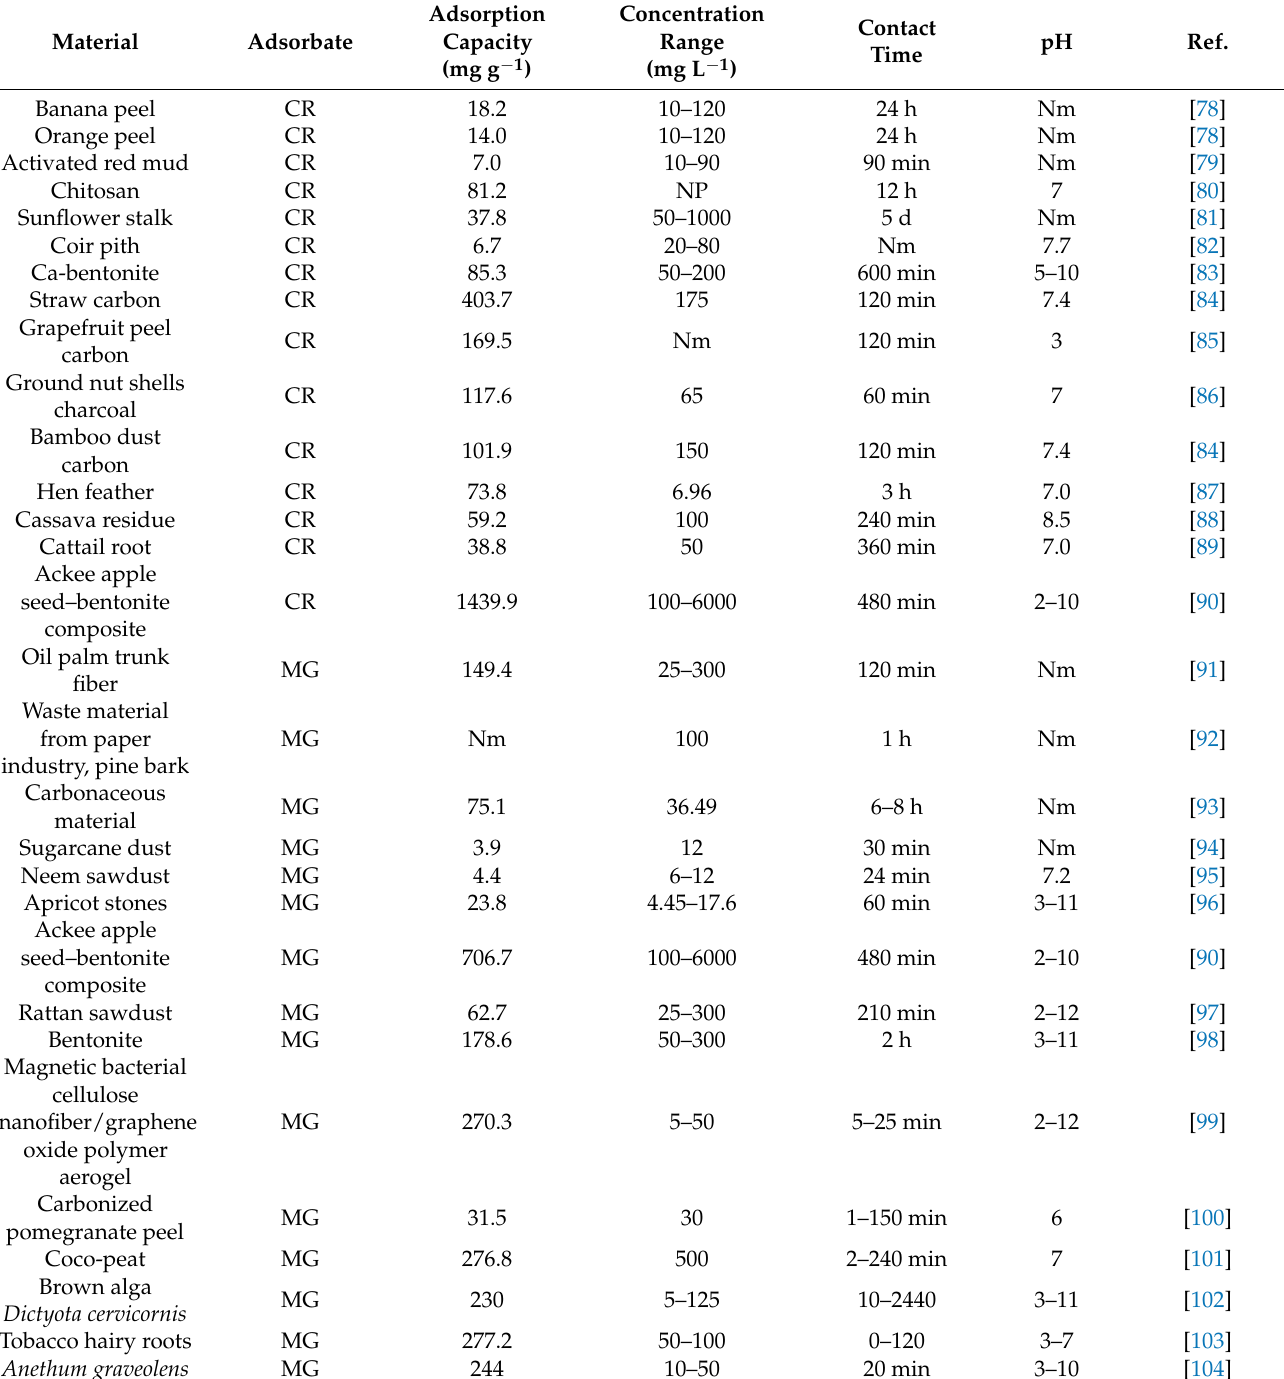
Table 4. Organic and inorganic adsorbents used for the removal of Congo red and malachite green